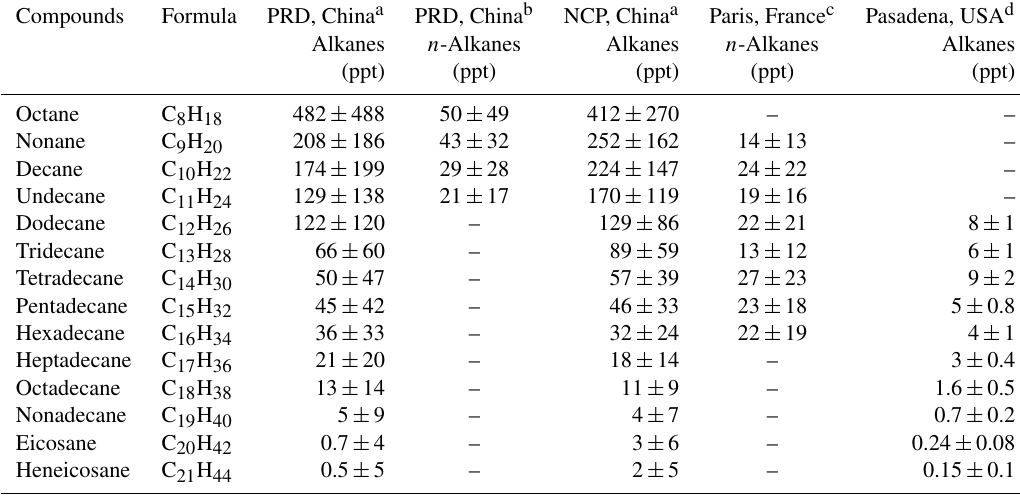
Table 2. Mean concentrations of alkanes (C8–C21) in different sites worldwide. Compounds